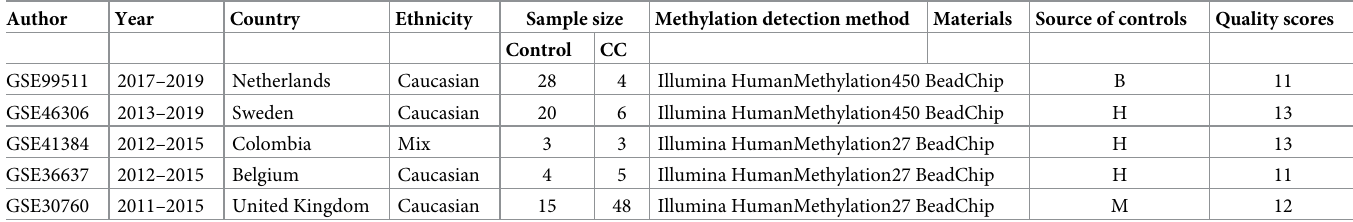
Table 8. Characteristics of included GEO datasets in this meta-analysis.